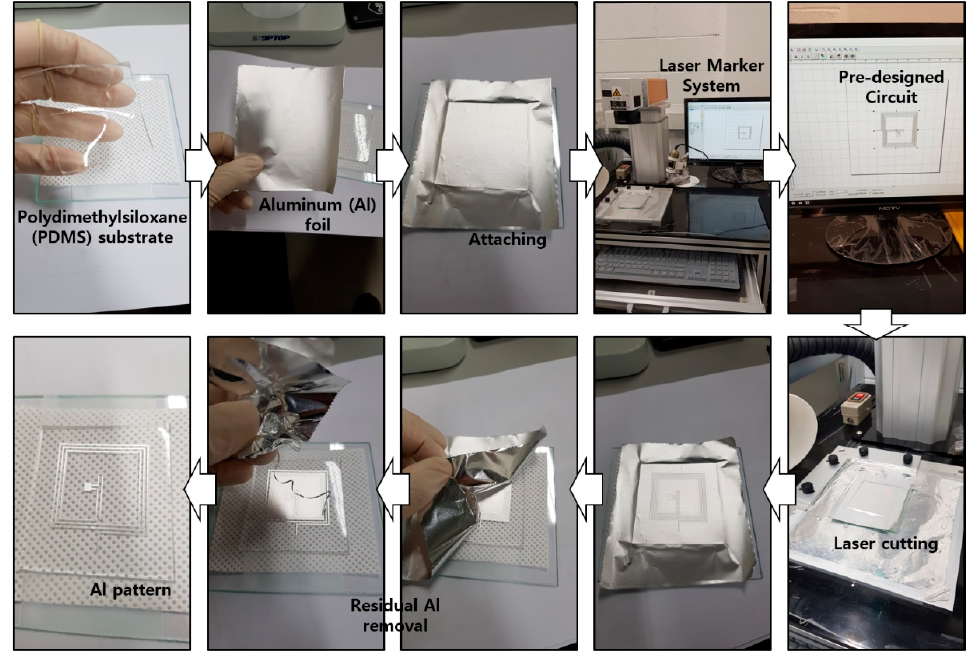
Figure A4 . Fabrication procedure of the aluminum (Al) circuit pattern. The Al foil was etched with a predesigned pattern, using a laser marking system. Finally, residual Al was removed.